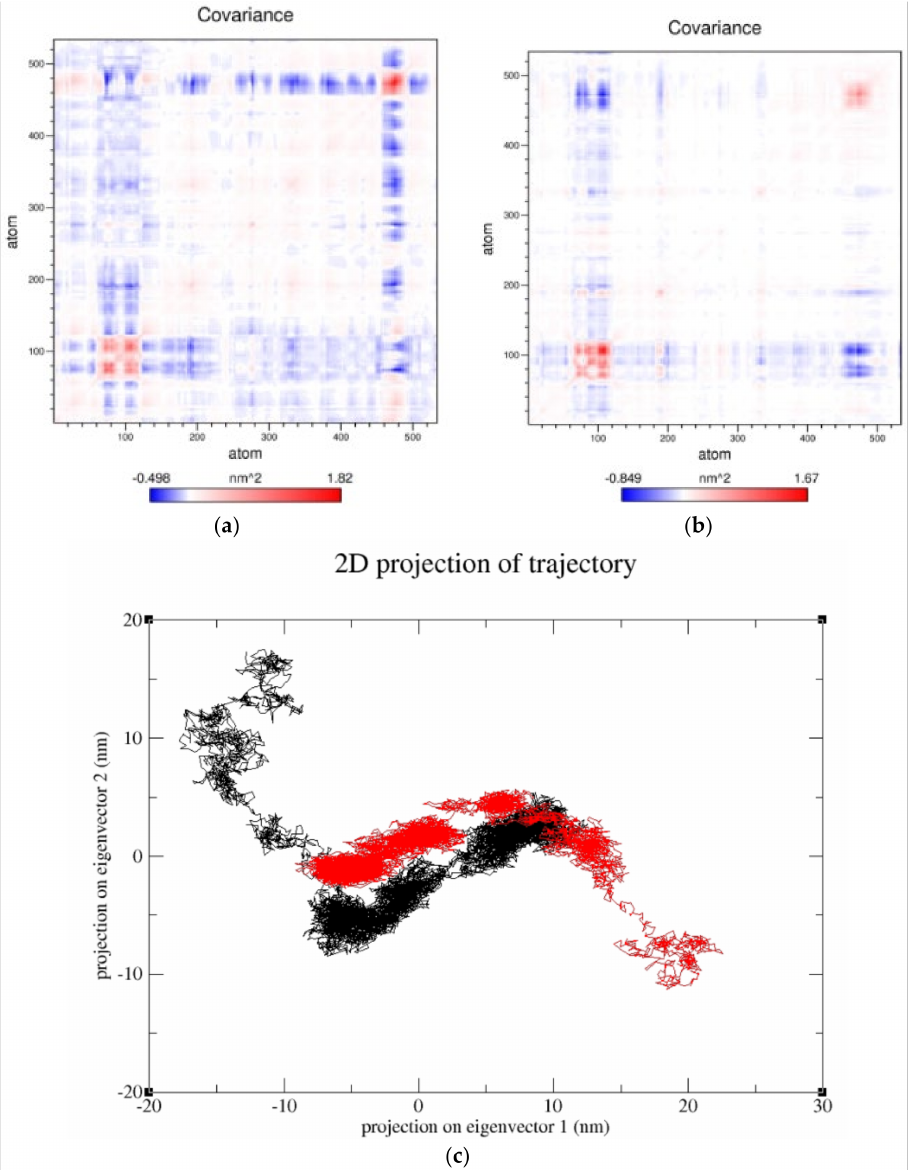
Figure 8. Principle component analysis (PCA). ( a ) Covariance matrix of ACCase–fenoxaprop -p-ethyl and ( b ) ACCase–sinigrin complexes. ( c ) 2D projection motion of fenoxaprop-p-ethyl (black) and sinigrin (red) complex protein in phase space with the first two